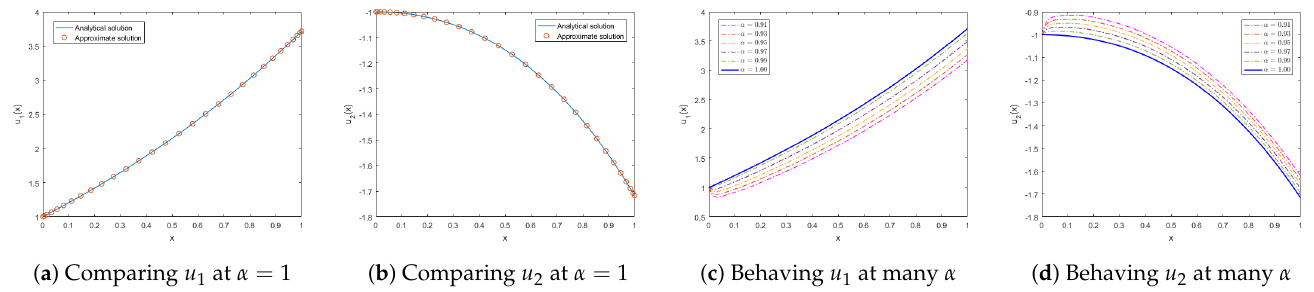
Figure 1. The behaviors of the approximate solutions in Example 1. ( a , b ) depict the comparisons between analytical and numerical solutions u 1 ( x ) and u 2 ( x ) with M = 30 and α 1 = α 2 = 1. The error analysis again verifies that at several values of α ∈ { 0.91,0.93,0.95,0.97,0.99,1 } , the obtained numerical solutions converge to the integer order solutions which their behaviors are also displayed in ( c , d ).